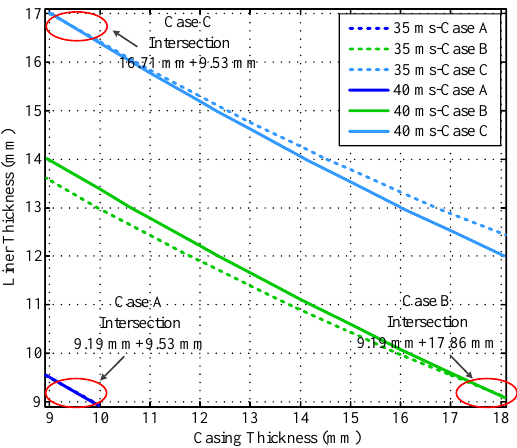
Figure 5. Intersection of induced EMF contour curves at 35 and 40 ms.